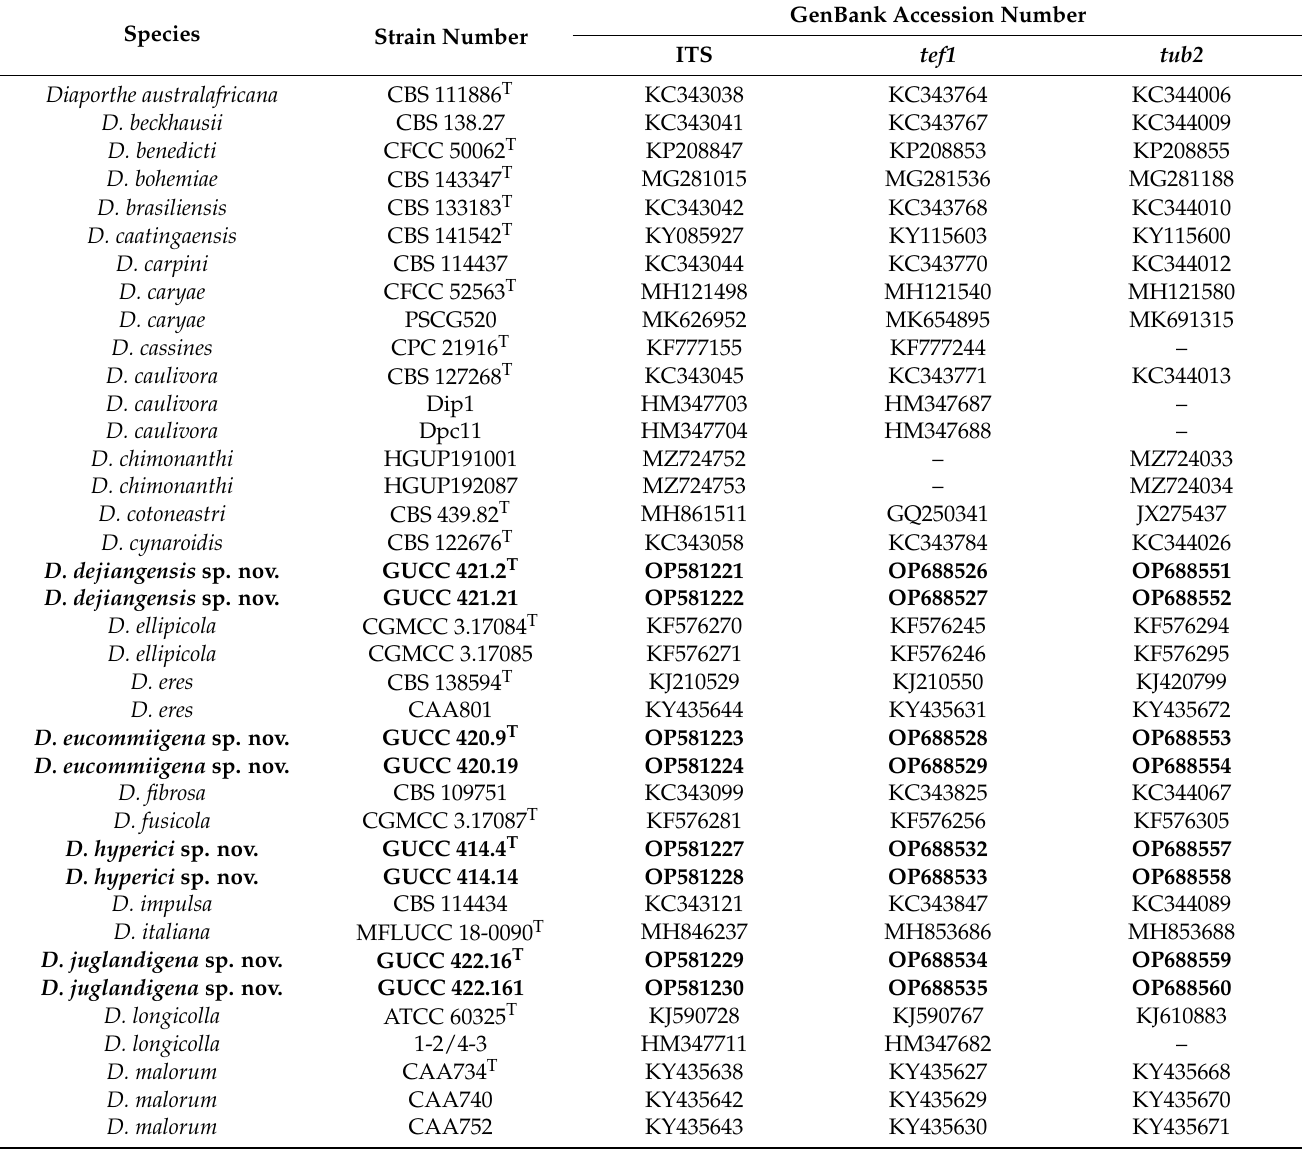
Table 3. Strains and their GenBank accession numbers used in the molecular phylogenetic analyses of Diaporthe . Newly generated sequences are in bold. ( T ) = ex–type